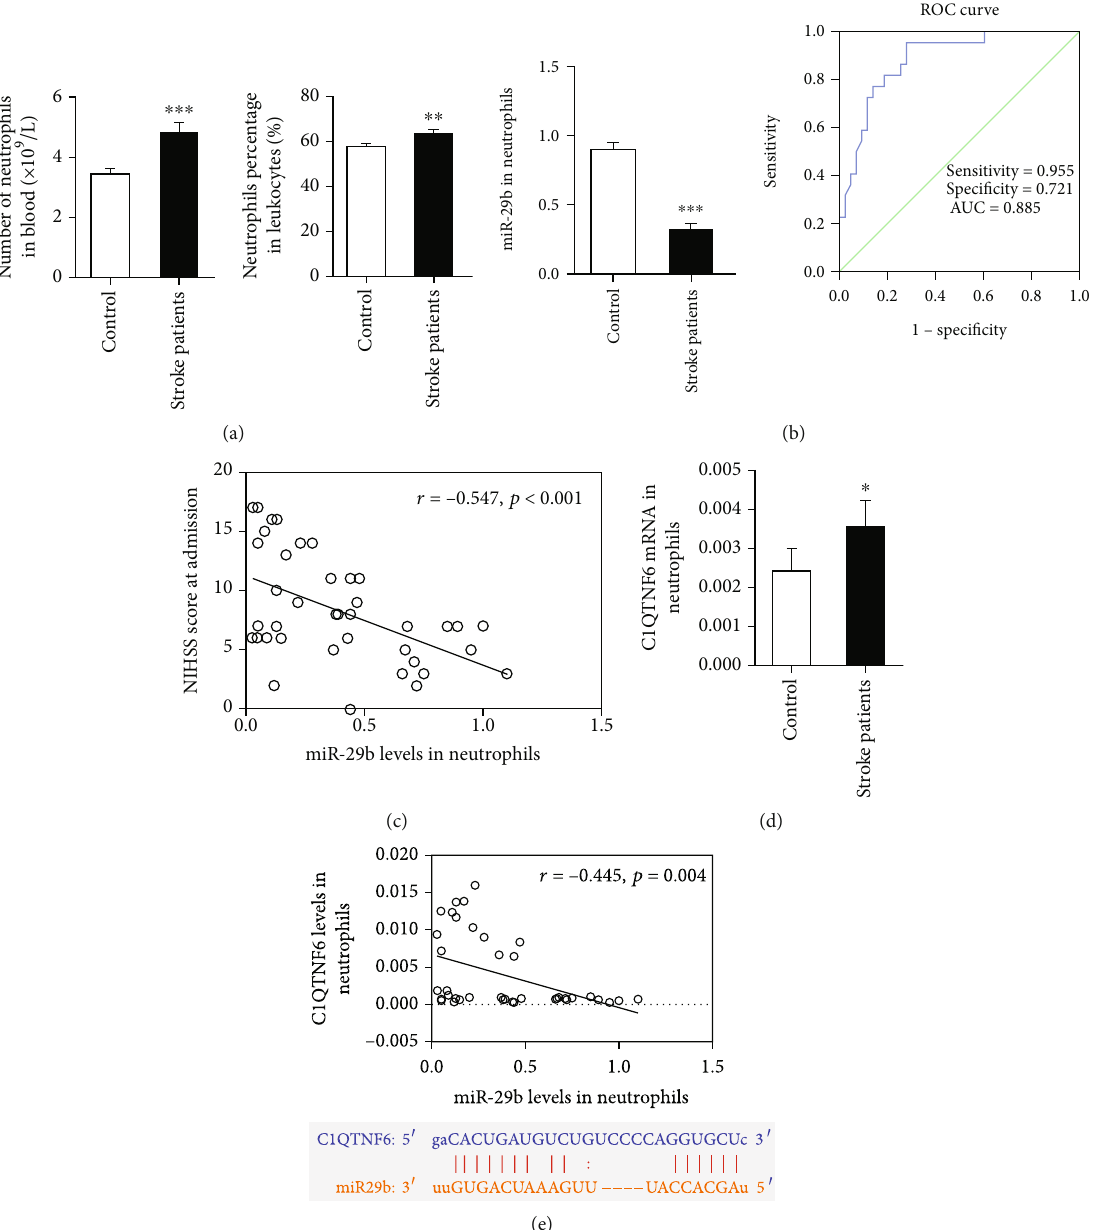
Figure 1: Neutrophilic miR-29b levels are signi fi cantly lower in stroke patients and show strong diagnostic value. (a) The number and percentage of neutrophils in stroke patients. (b) miR-29b levels in neutrophils of stroke patients. Receiver operating characteristic (ROC) curve of miR-29b in diagnosing ischemic stroke. (c) Correlation between miR-29b expression and National Institute of Health Stroke Scale (NIHSS) score at admission. (d) C1QTNF6 mRNA levels in neutrophils of ischemic stroke patients. (e) Correlation between miR-29b and C1QTNF6 expression at admission. The predicted binding sites between miR-29b and C1QTNF6. N = 60 in stroke group and N = 40 in control group. ∗ P < 0 : 05 , ∗∗ P < 0 : 01 , and ∗∗∗ P < 0 : 001 vs. control group. AUC indicates area under the ROC (Figure 1(d); P < 0 : 05 ). miR-29b levels were found to be neg- (Figure 1(c); R = − 0 : 547 , P < 0 : 001 ).